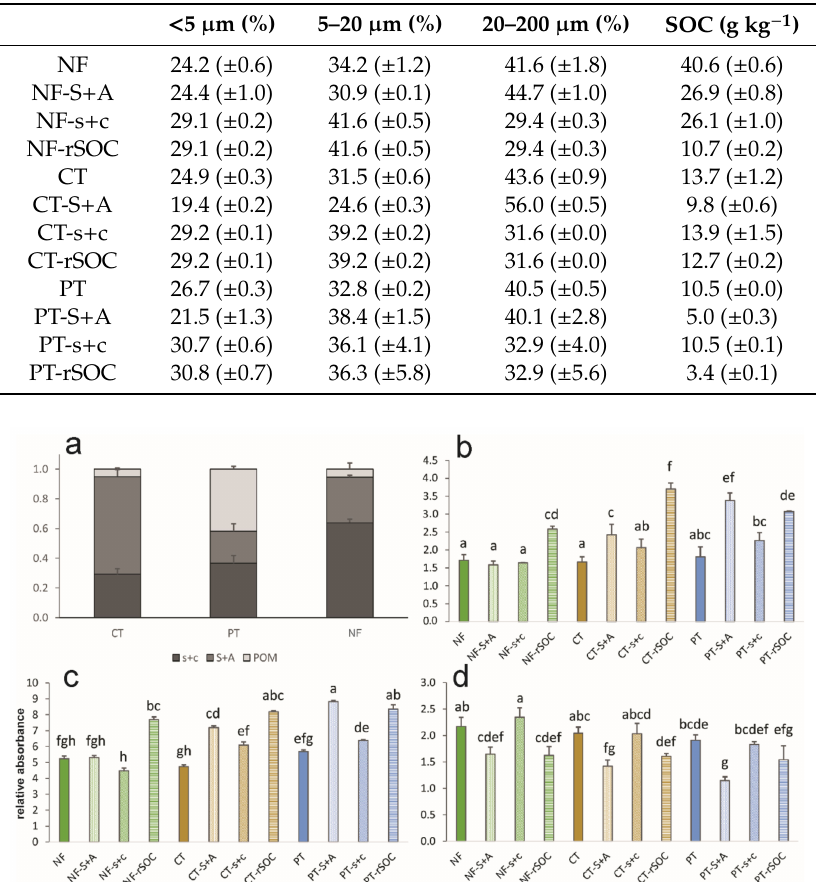
Table 1. Particle size distribution and total organic carbon content of the investigated fractions under various land use types (SOC: soil organic carbon; NF: native forest; CT: conservation tillage; PT: ploughing tillage). Standard deviations are in brackets.